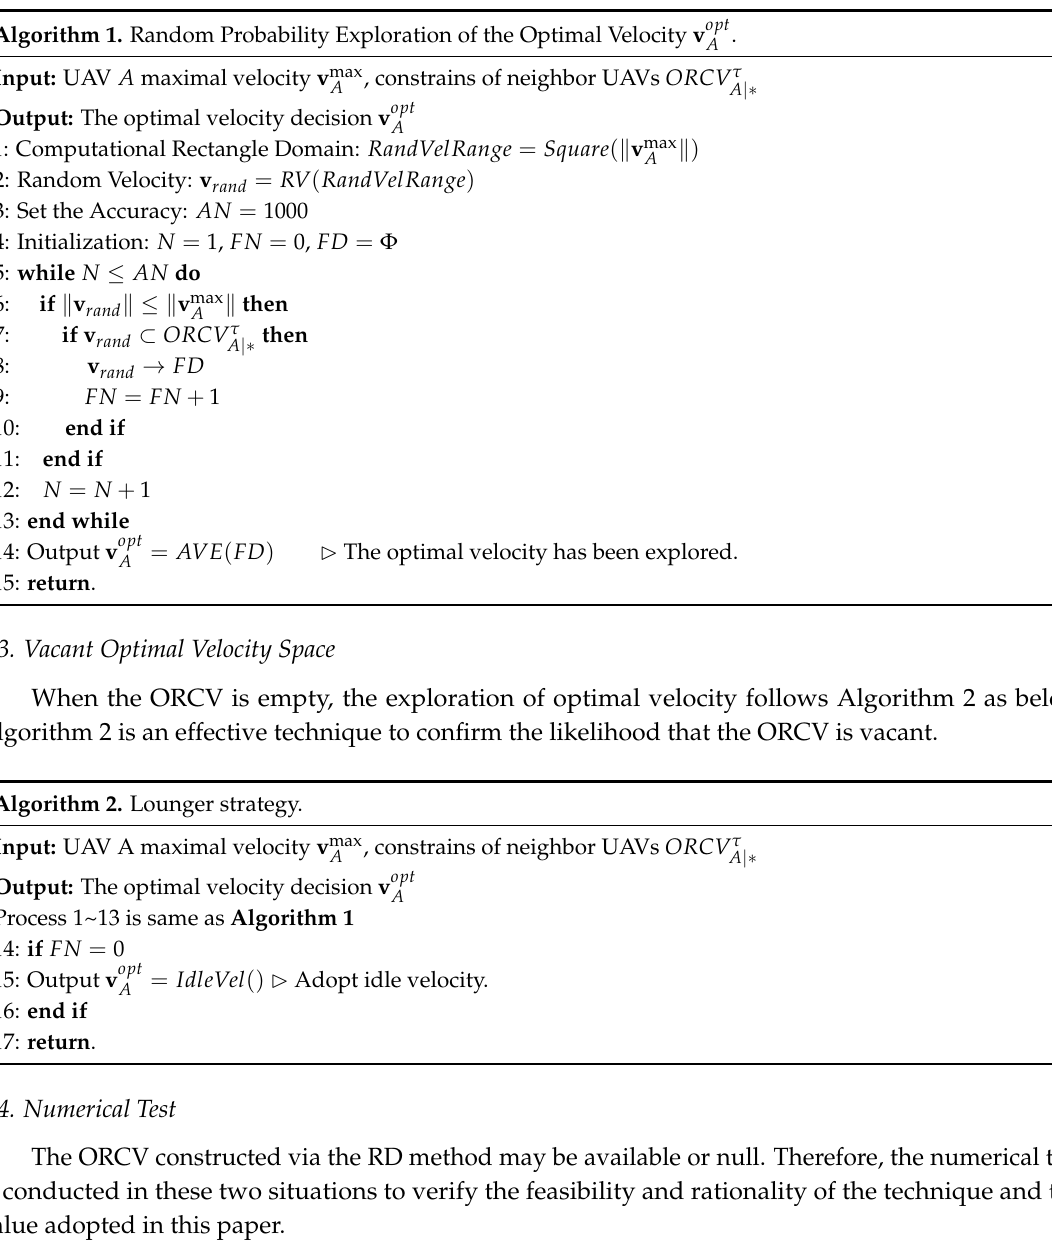
Algorithm 1. Random Probability Exploration of the Optimal Velocity v opt